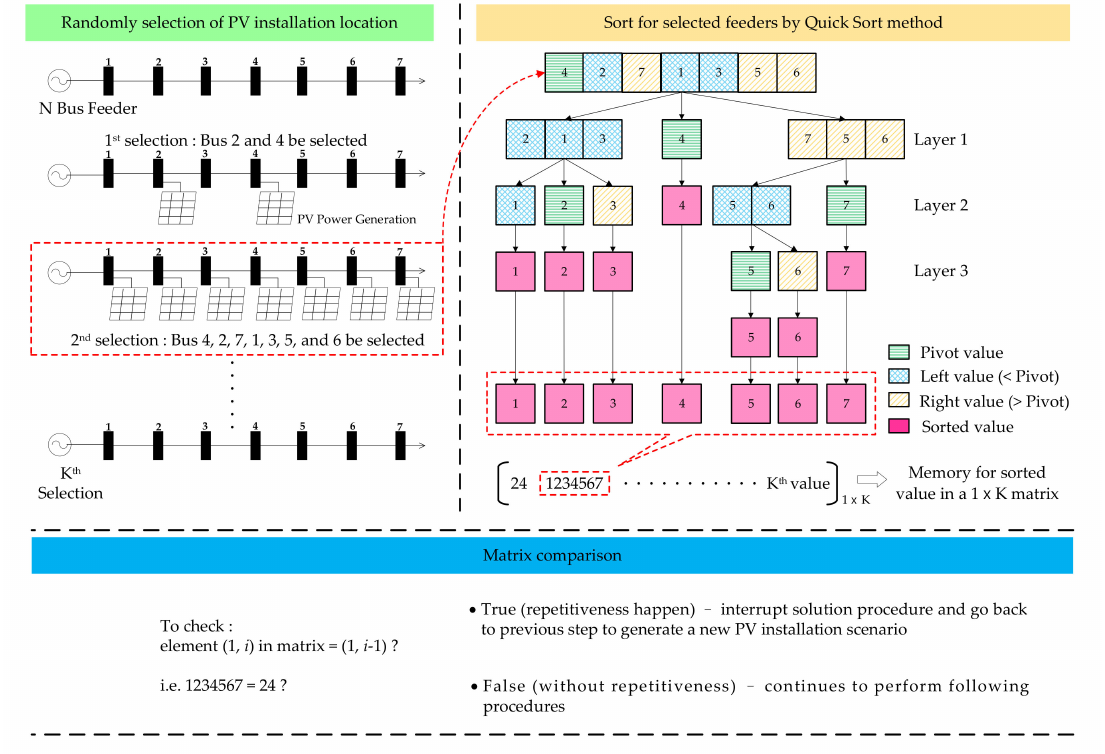
Figure 4. Example for the illustration of repetitiveness check mechanism in